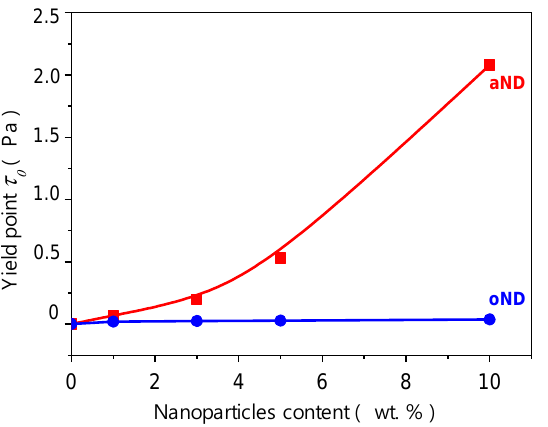
Figure 2. Effect of the nanoparticles content on the yield points of the HDPE-based composite fibers.